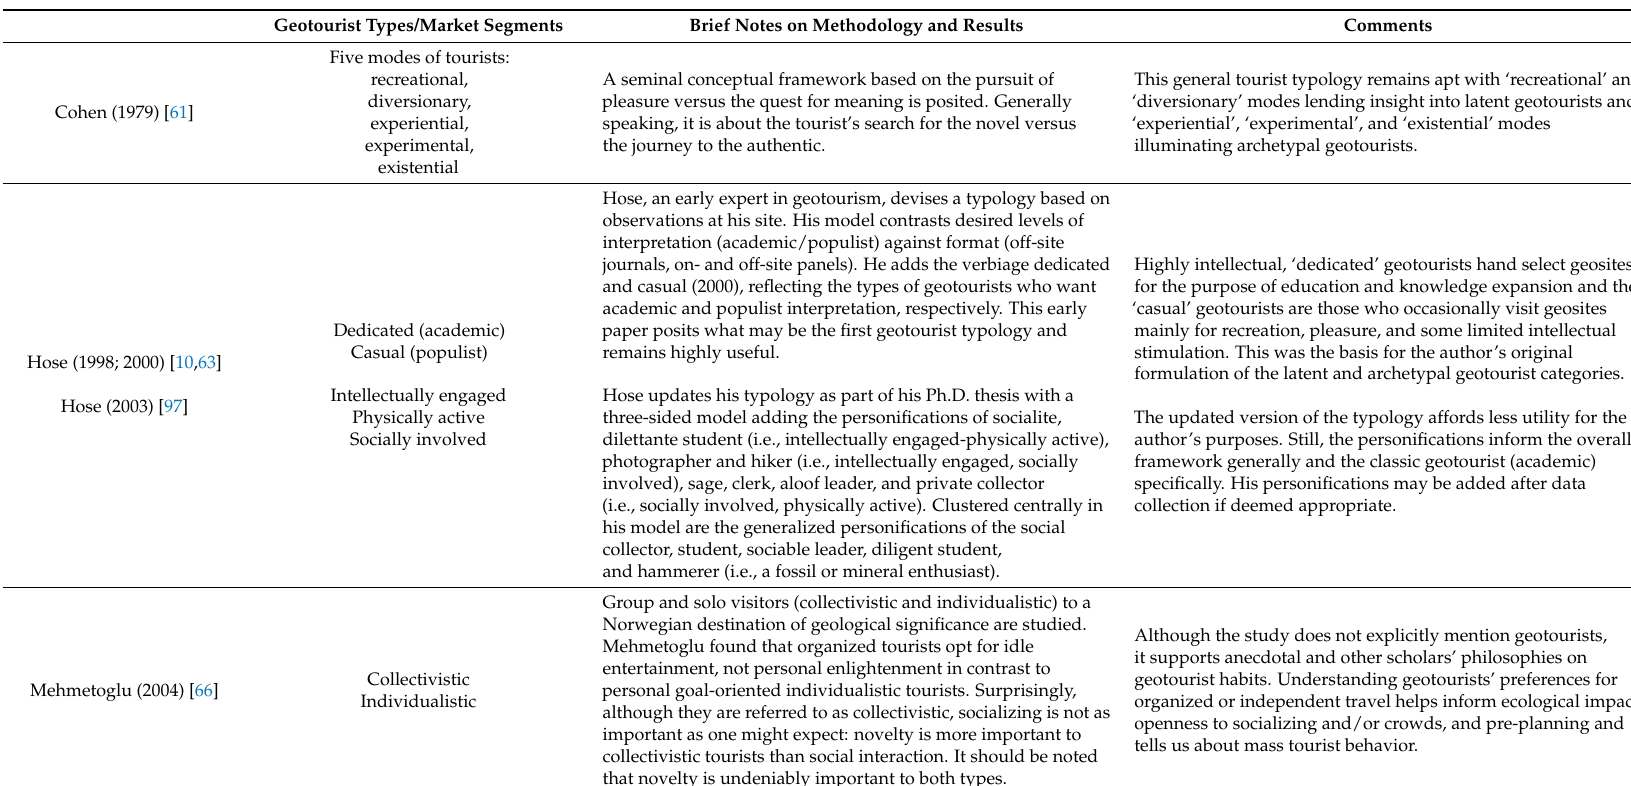
Table A1. An Overview of the Literature Describes the General Placement of Select Texts within the New Conceptual